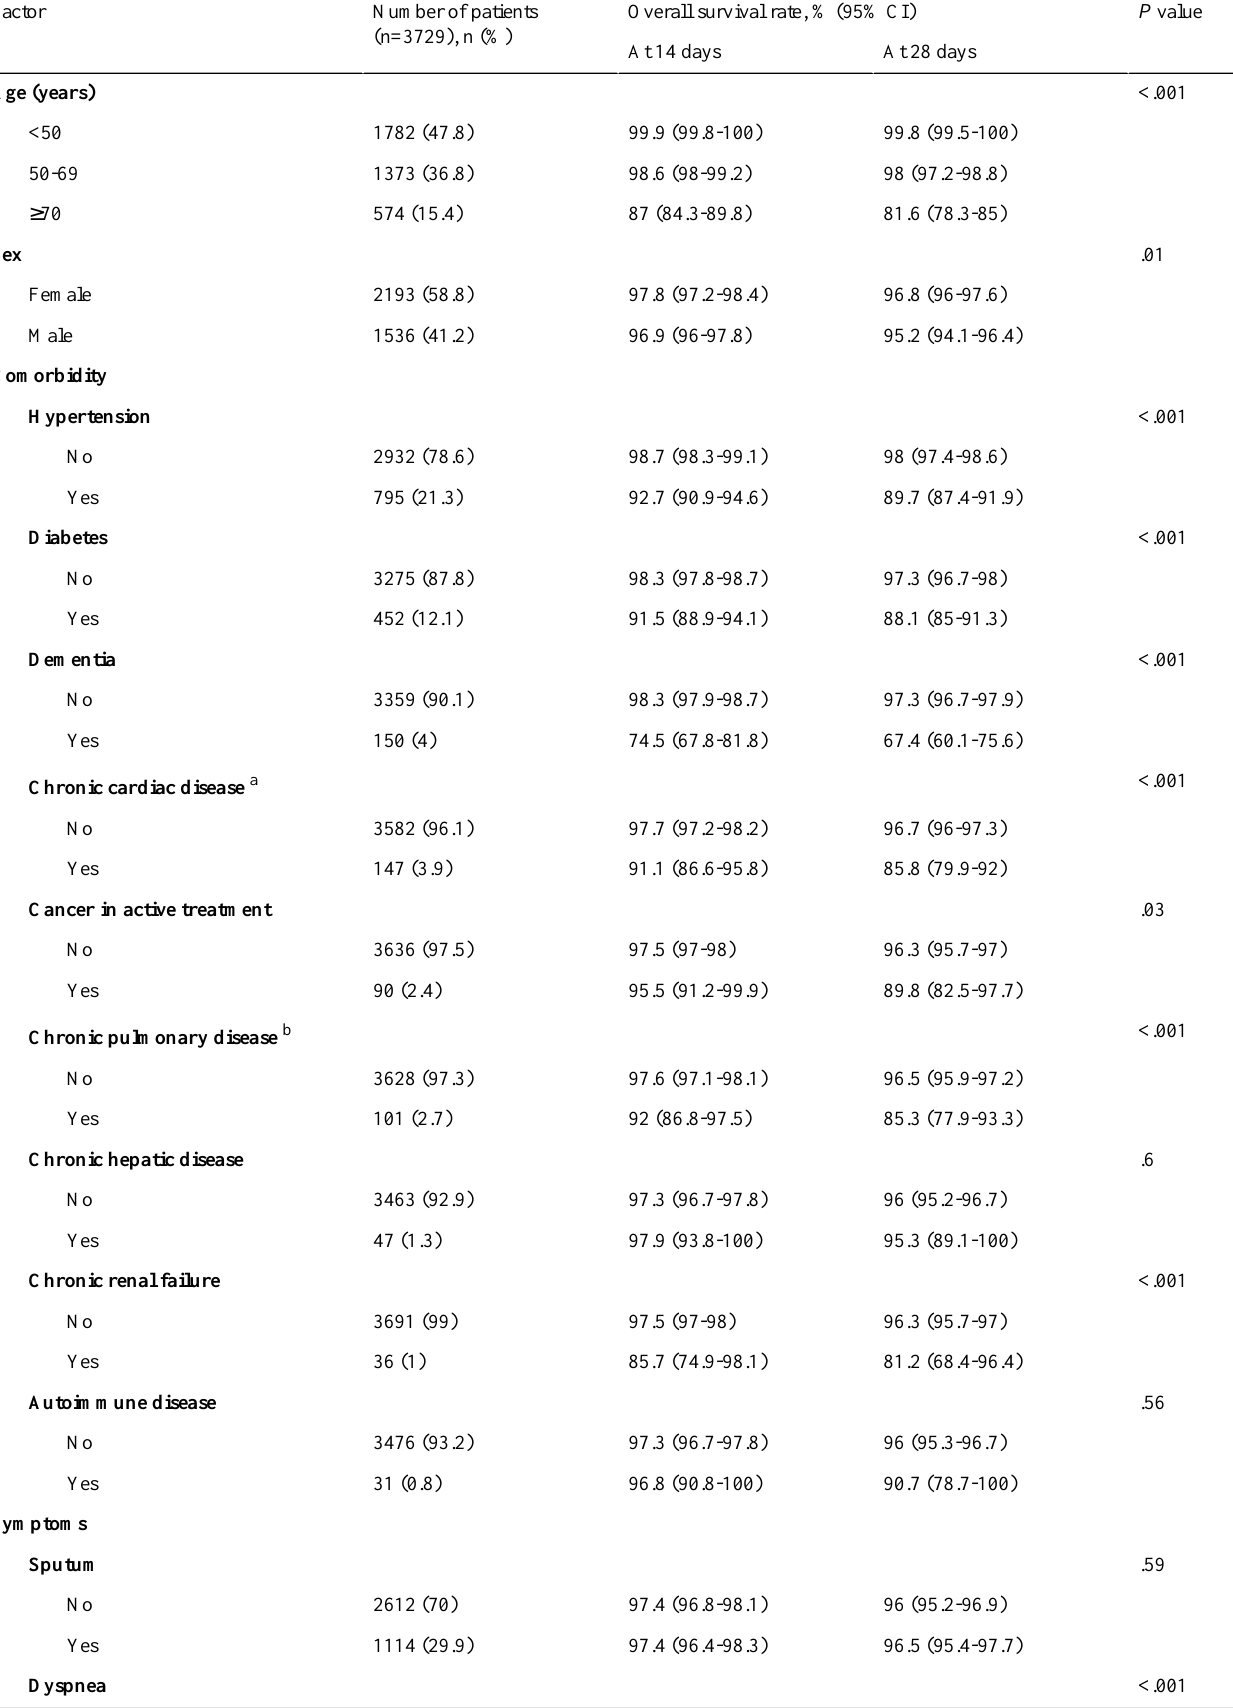
Table 2. Univariable analysis for potential factors associated with overall survival in the development cohort. All values presented in the table represent data collected at the time of initial COVID-19